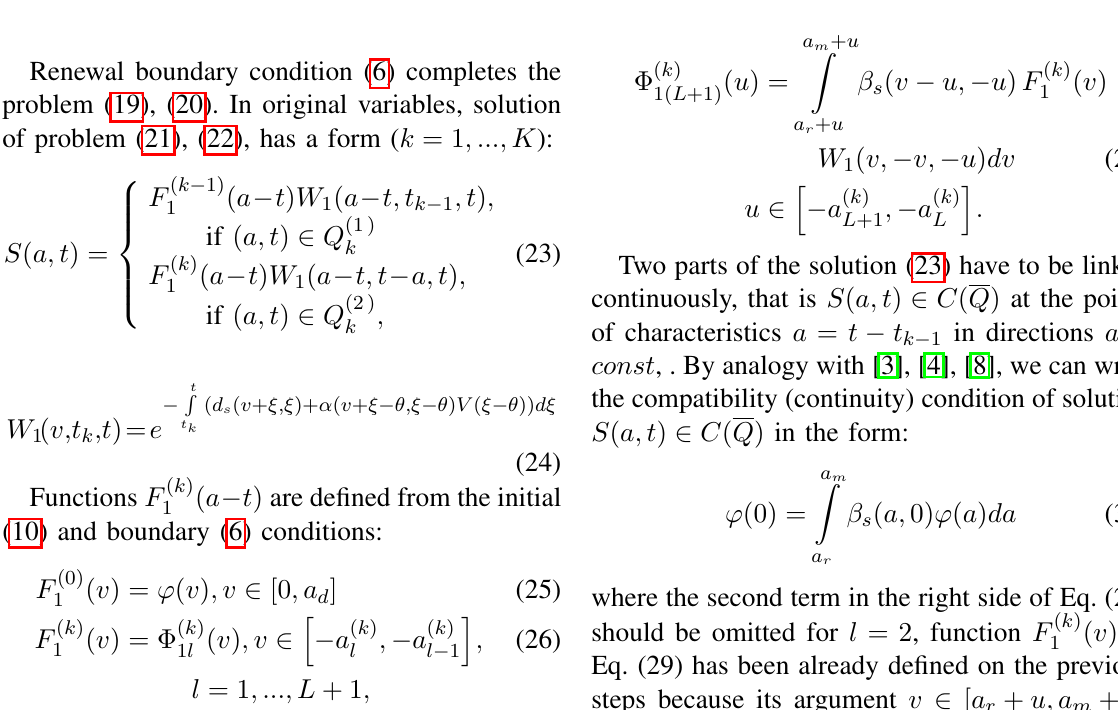
Fig. 1. Splitting of domain ¯ Q and the age intervals (cid:104) (cid:105) a (1) , a (1) , for l = 0 , ..., L l l +1